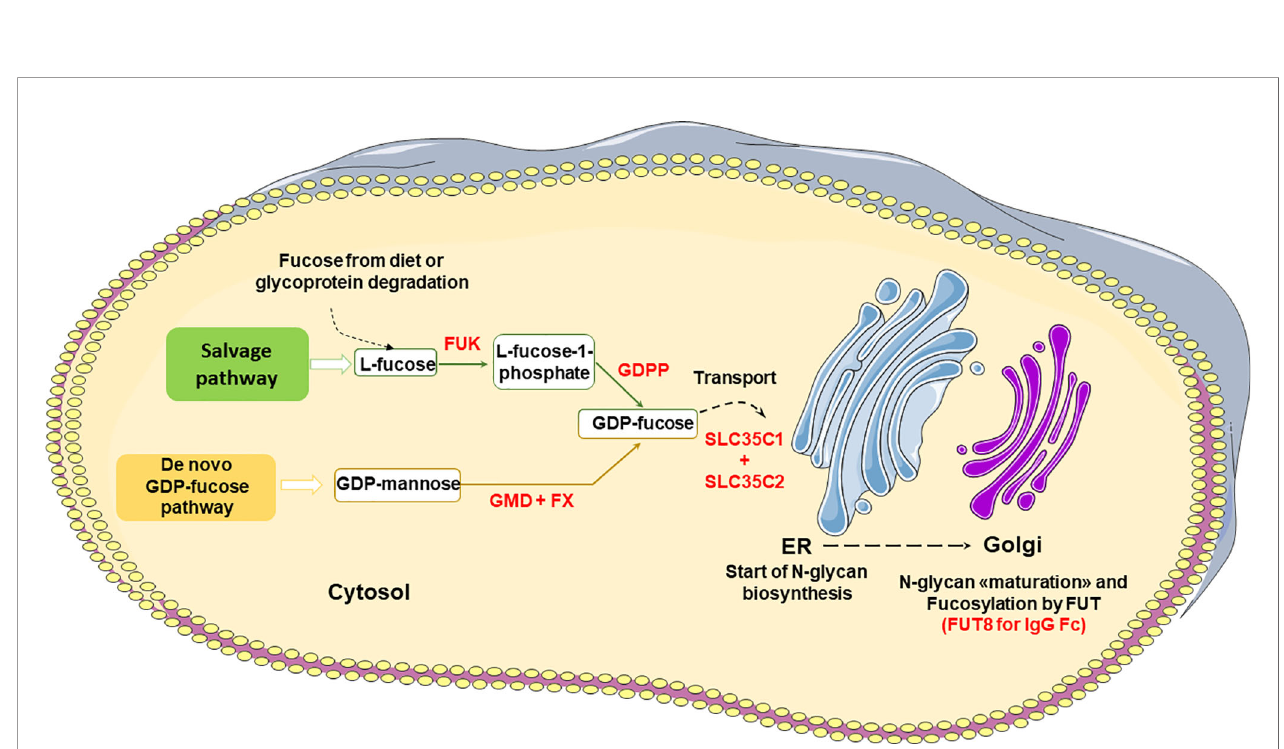
FIGURE 3 | Major pathways of GDP-fucose biosynthesis and IgG Fc core fucosylation. FUK, Fucose Kinase; GDPP, GDP-fucose-pyrophosphorylase; GMD, GDP- mannose 4,6 dehydratase; FX, GDP-4-keto 6-deoxymannose 3,5-epimerase-4-reductase; FUT, Fucosyltransferase.